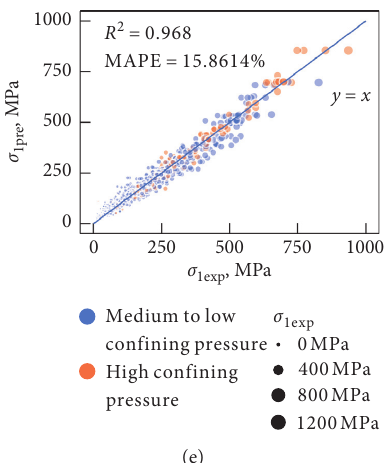
Figure 7: Predicted vs. experimental σ 1 values when all data available. (a) Pariseau n equation. (d) Nonlinear empirical equation. (e)